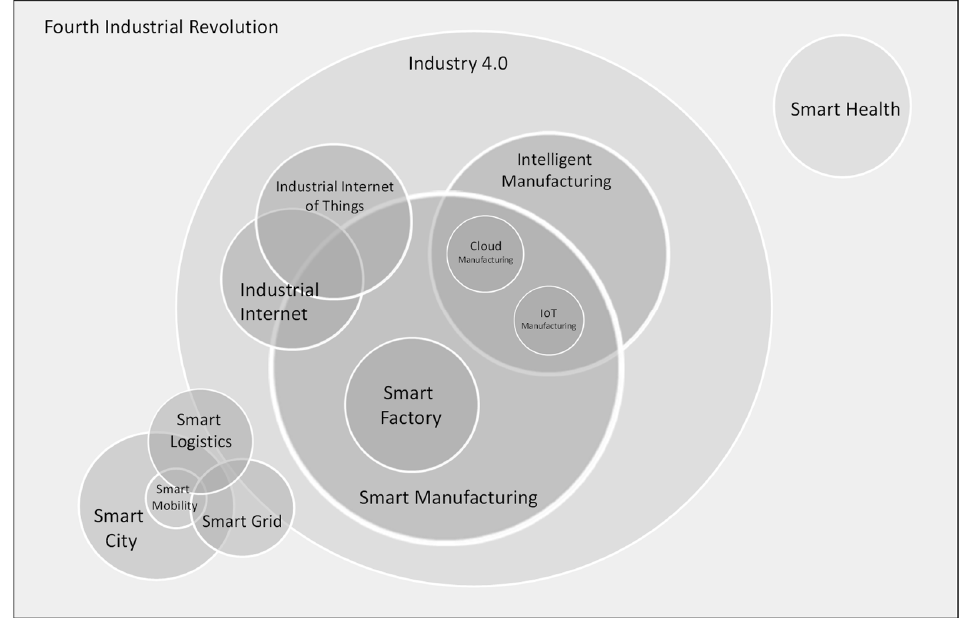
Figure 1. The concept of smart manufacturing in context [3].